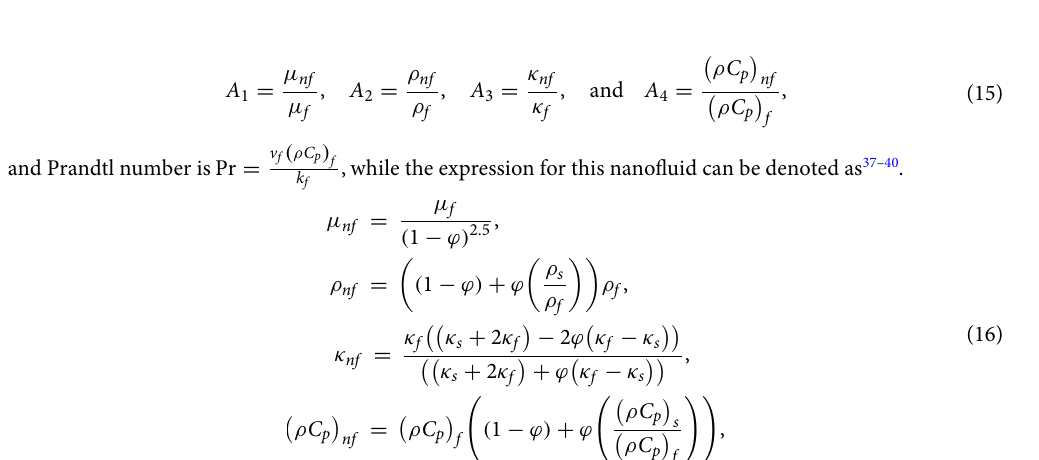
Table 1. Thermophysical properties of fluids and nanofluids studied here.